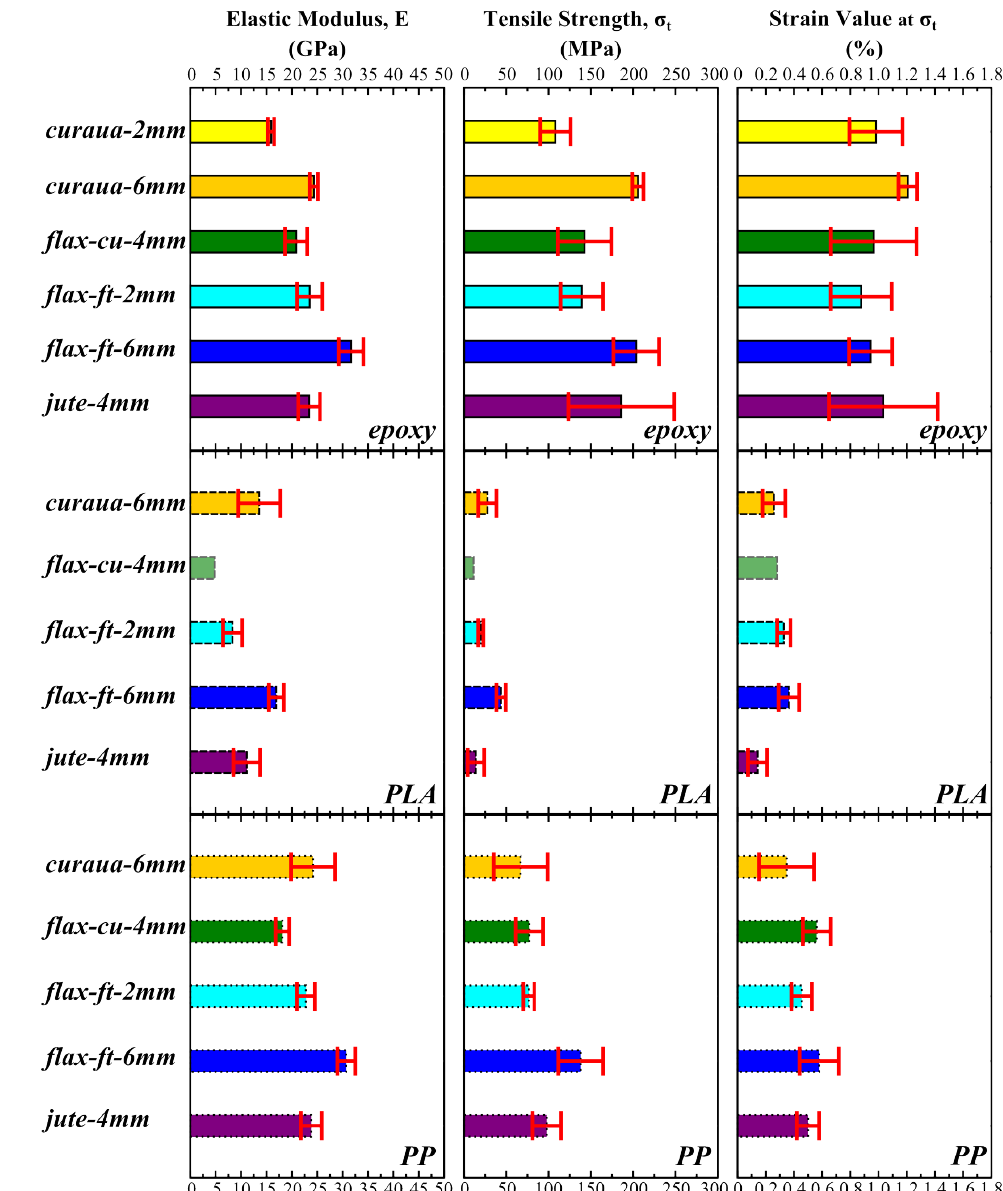
Figure 8. The mechanical properties of aligned discontinuous natural fibre composites, elastic moduli, tensile strength ( σ t ) and strain at σ t , respectively, from left to right. Top to bottom: epoxy (solid line), PLA (dashed line), and PP (dotted line). Error bars indicate standard deviation